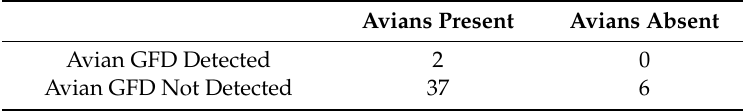
Table A2. Self-reported presence of avian species with detection of Avian GFD molecular marker in stored water.